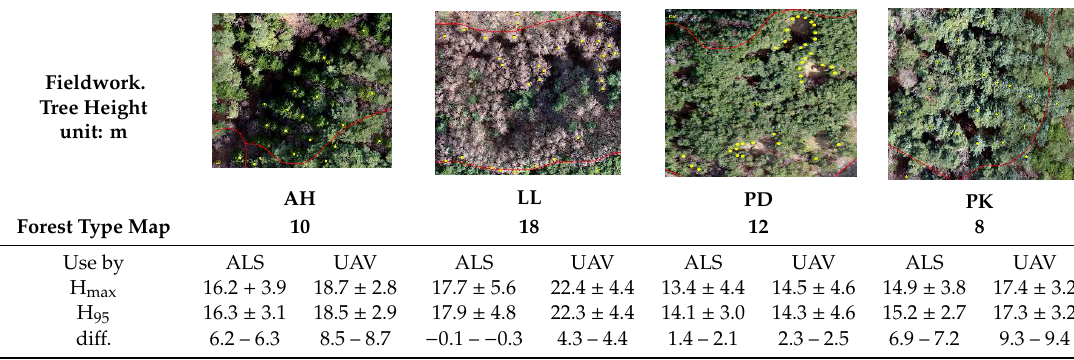
Table 11. Comparison of tree heights according to the forest type map and fieldwork (unit: m).